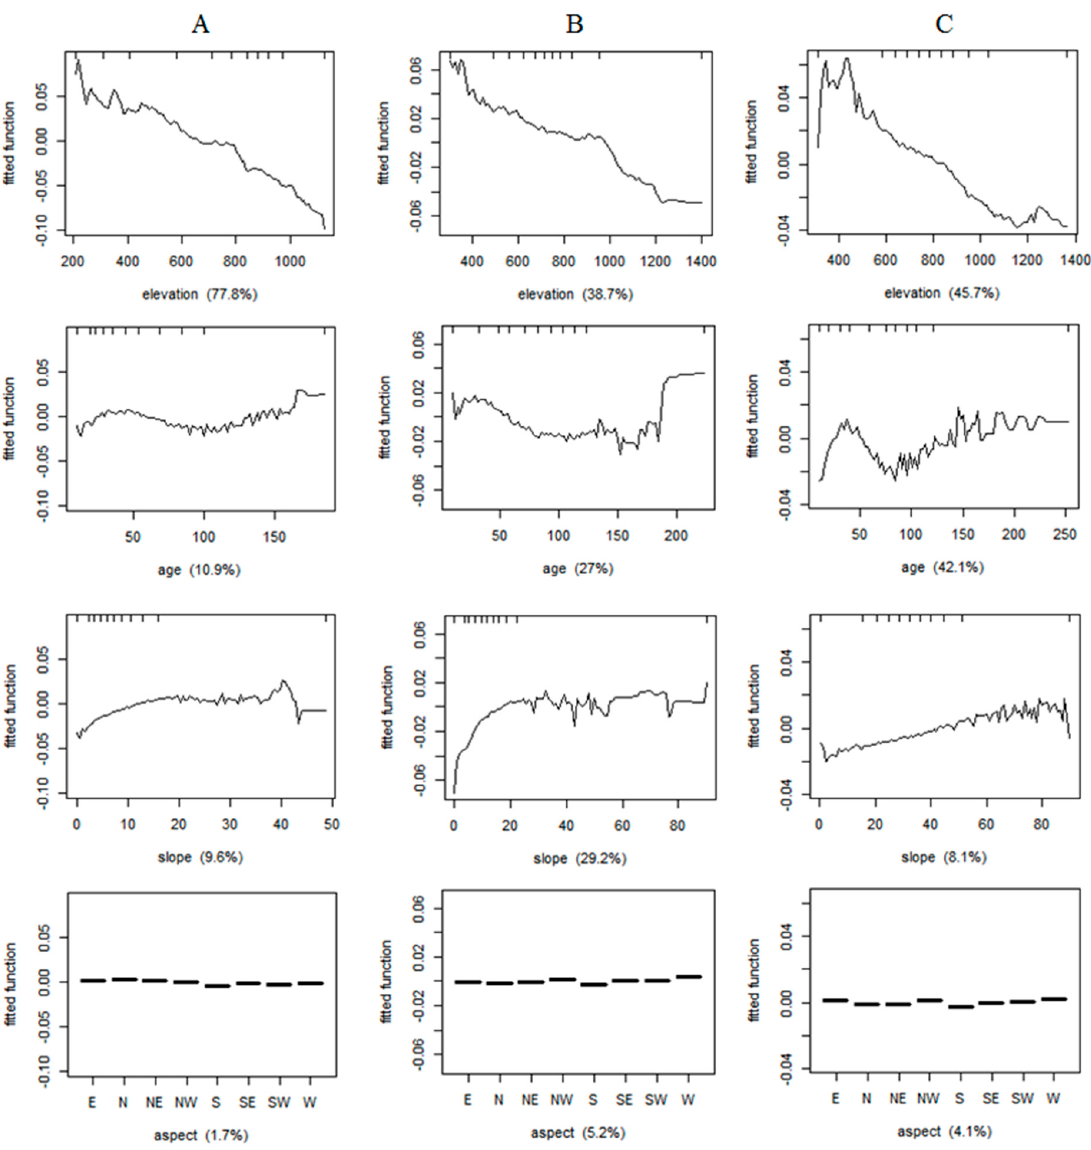
Figure 8. Partial regression plots between predictors and average values of NDRE for area A, B and C.